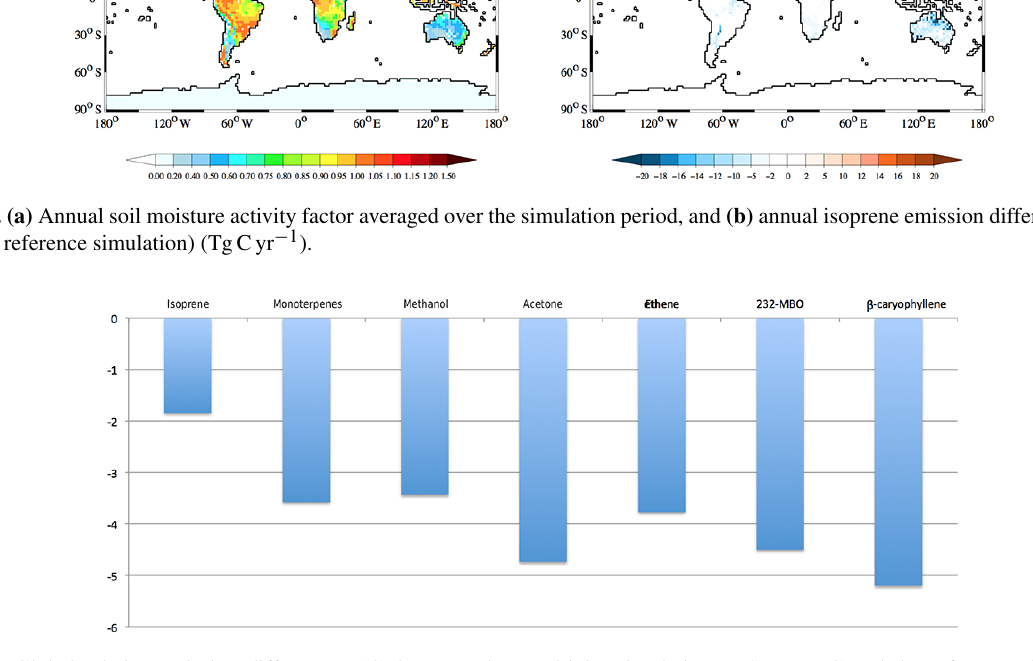
Figure 12. Global relative emission differences (%) between the sensitivity simulation TEST-NUDG and the reference simulations for isoprene, monoterpenes, methanol, acetone, ethene, 232-MBO, and β